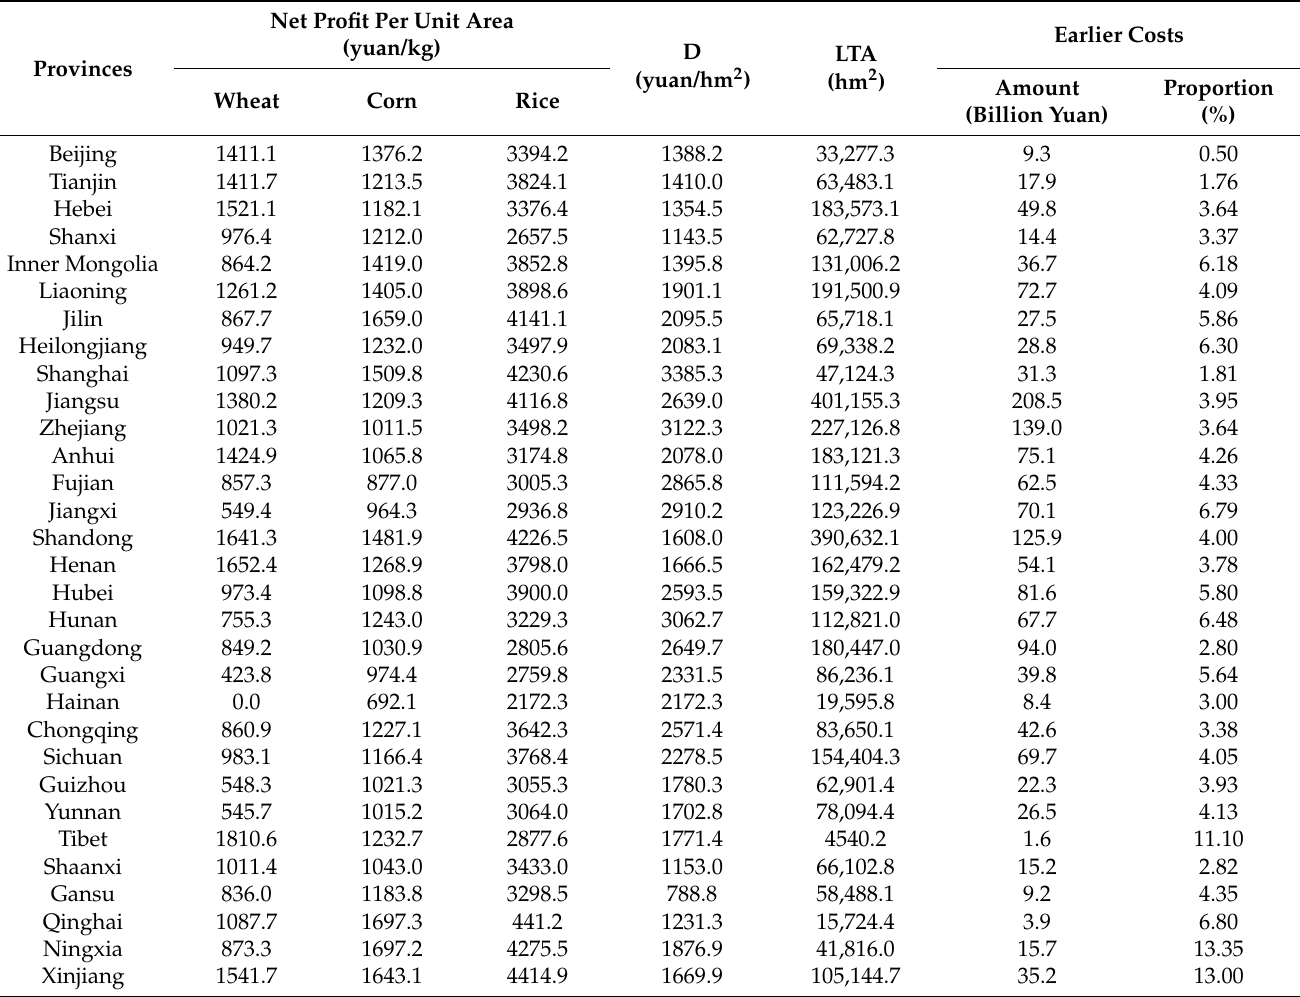
Table 1. Ecological cost in the early stage of the land finance model and its proportion in fiscal land funds for the 31 provinces in China from 2003 to